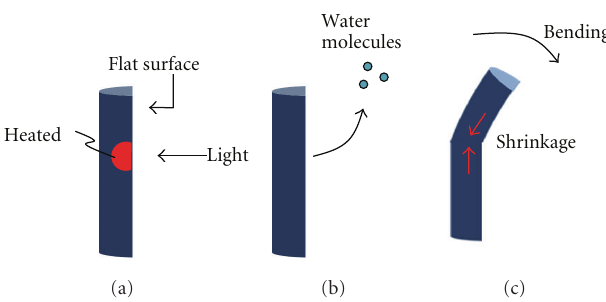
Figure 5: Mechanism of bending behavior of the PAA/MB